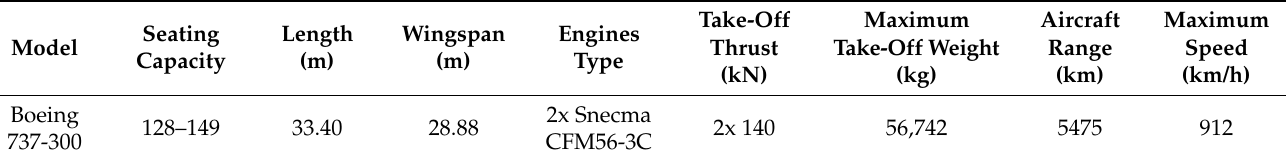
Table 1. Basic technical data of the Boeing 737-300 aircraft [28].